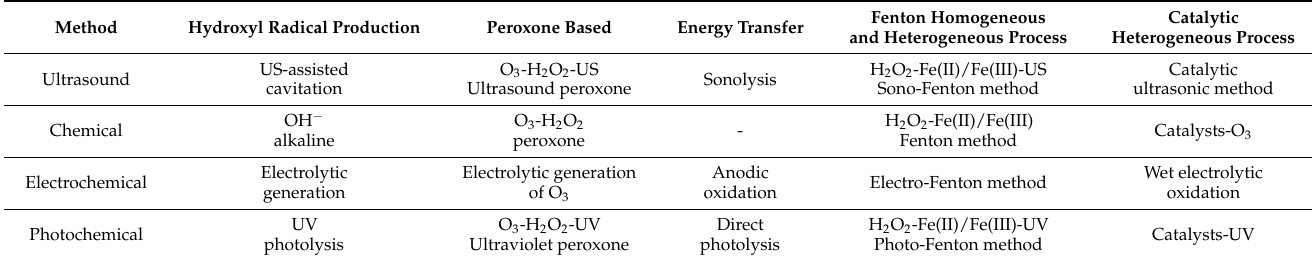
Table 2. AOPs’ classification based on formation of hydroxyl